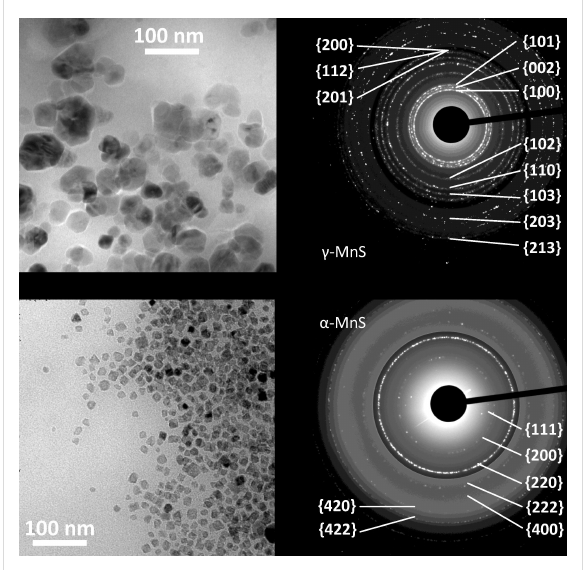
Figure 4: TEM images (left) and electron diffraction patterns (right) of NCs obtained by high temperature decomposition of MnSt 2 with S/Mn = 2 and L/Mn = 4. (a) γ -MnS NCs synthesized using L = HdAm; (b) α -MnS NCs synthesized using L = DdTh (where DdTh =